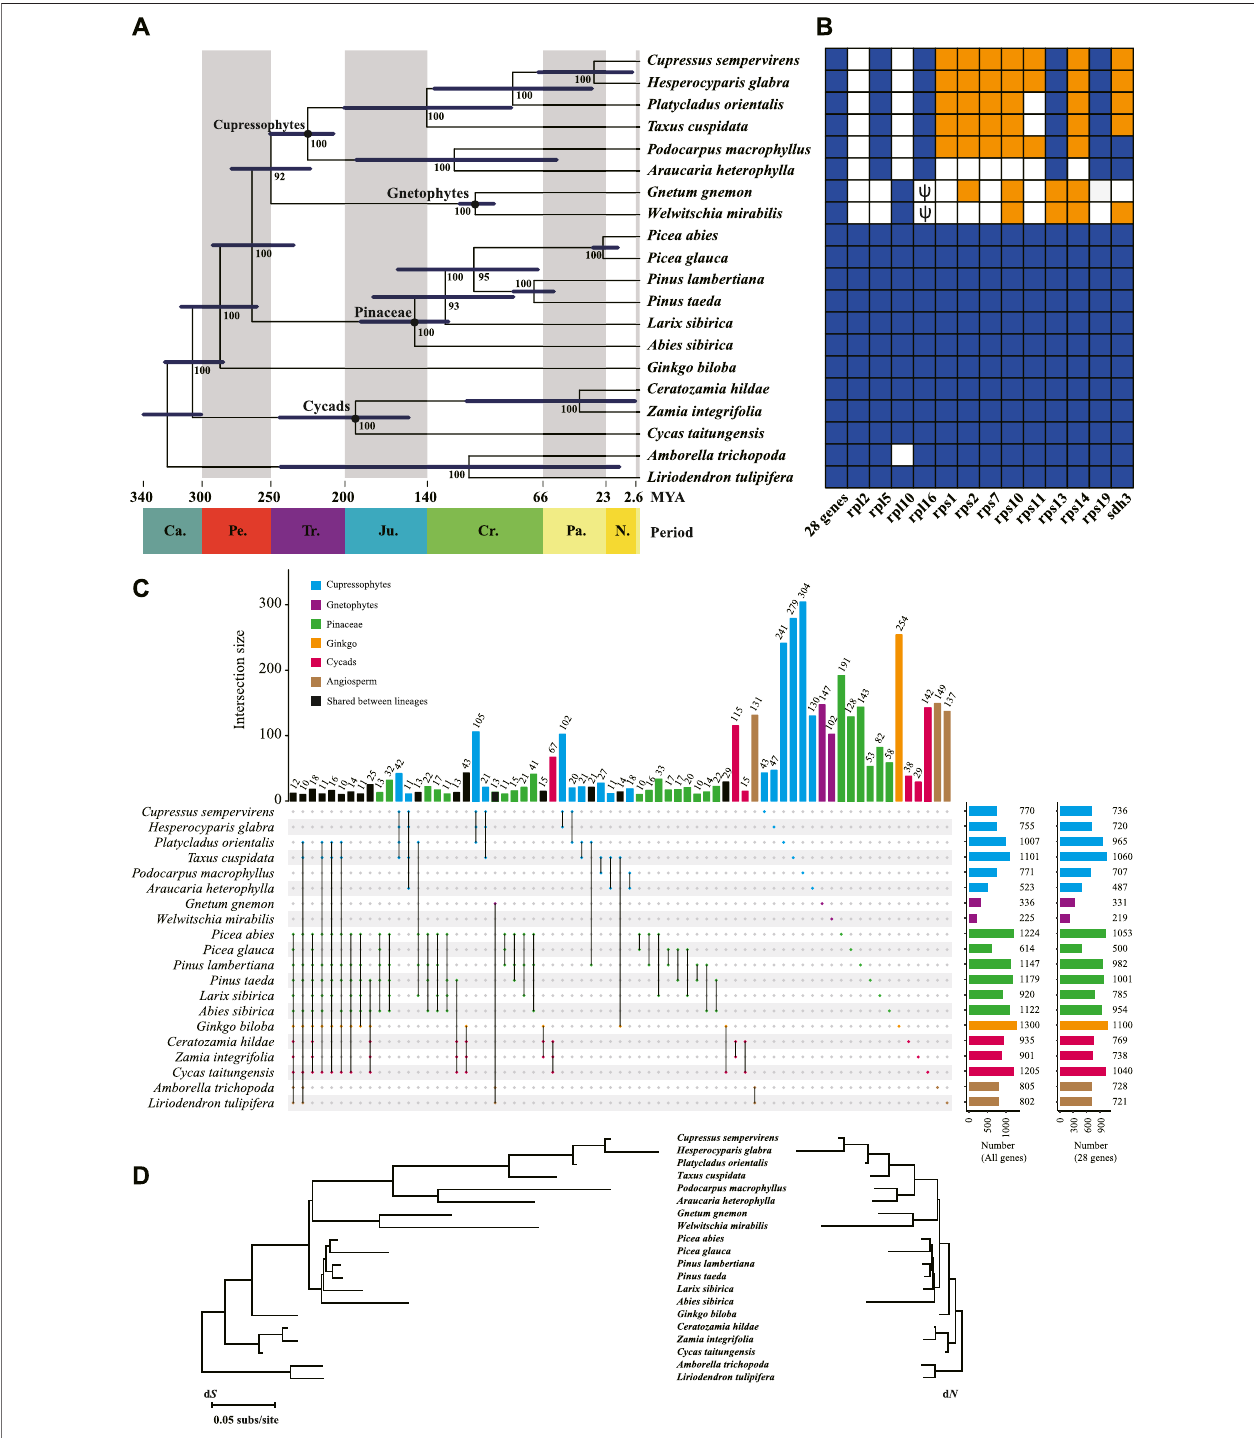
FIGURE2| Phylogenyandgenecontentofthe20mitogenomesincludedinthisstudy. (A) Thephylogenetictreeamongmajorgymnospermlineagesbasedon28 shared genes. Numbers next to nodes indicate bootstrap values from 1,000 replicates, and blue bars correspond to the 95% highest posterior density (HPD) of divergence time. Period is shown at the bottom of the tree. Ca., Carboniferous; Pe. Permian; Tr. Triassic; Ju. Jurassic; Cr. Cretaceous; Pa. Paleogene; N. Neogene. (B) Genecontentsinthe20mitogenomes.The28sharedgenesare atp [1,4,6,8,9], ccm [ B , C , Fc , Fn ], cob , cox [1 – 3], matR , mttB , nad [1,2,3,4,4L,5,6,7,9], rps [3, 4,12],and sdh 4.Intactgenesareindicatedbydarkblueblocksandmissinggenesinwhite.Thelostgenesthatarecon fi rmedastransferredtonucleusarehighlightedin orange.Pseudogenesareindicatedas ψ . (C) RNAeditingsitesinthe20mitogenomes.Thetwoplotsinthefarrightshowthenumberofeditingsitesforallgenesandthe 28 shared genes, respectively. (D) Nucleotide substitution rates in the 20 mitogenomes. Branch lengths are proportional to rates of synonymous (d S ) and nonsynonymous (d N ) substitutions inferred by the maximum-likelihood method implemented in PAML.